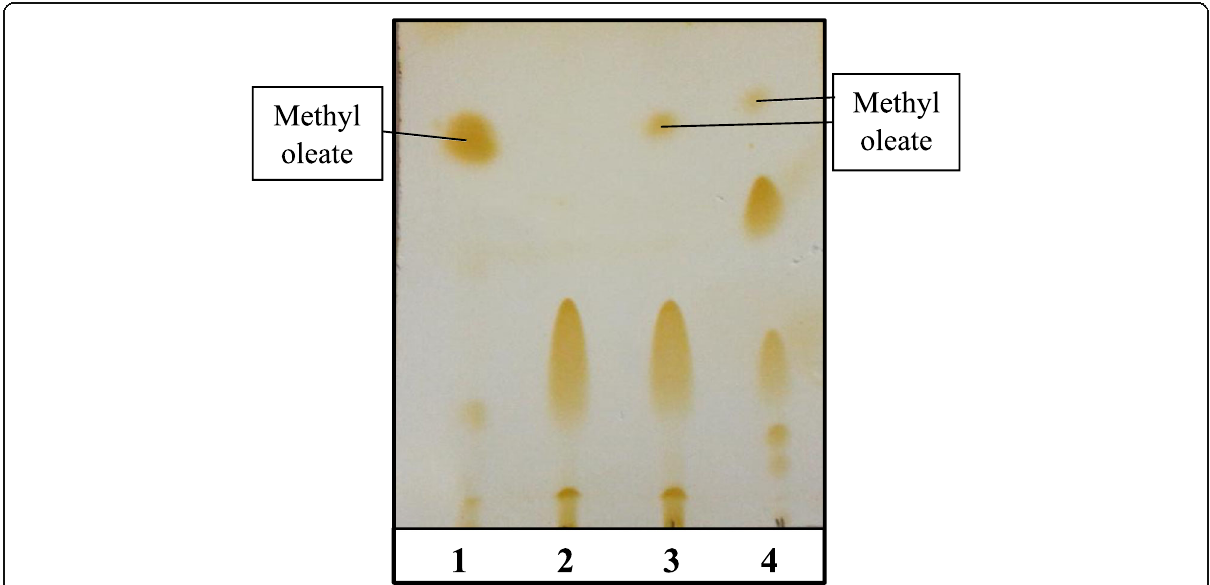
Fig. 9 Production of biodiesel by lipase produced by R. oryzae R1 through esterification and transesterification using TLC plate. Lane 1: Standard methyl oleate. Lane 2: Standard oleic acid. Lane 3: Esterification products (immobilized enzyme with oleic acid). Lane 4: Transesterification products (purified enzyme with olive oil)